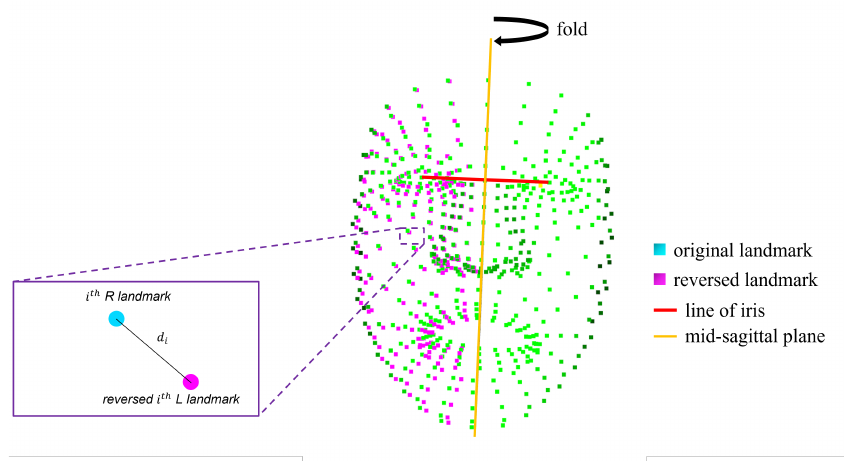
Figure 5. Distance symmetry. The distance from the inverted landmark (pink) after inverting the landmark on the left side of the face through the midsagittal